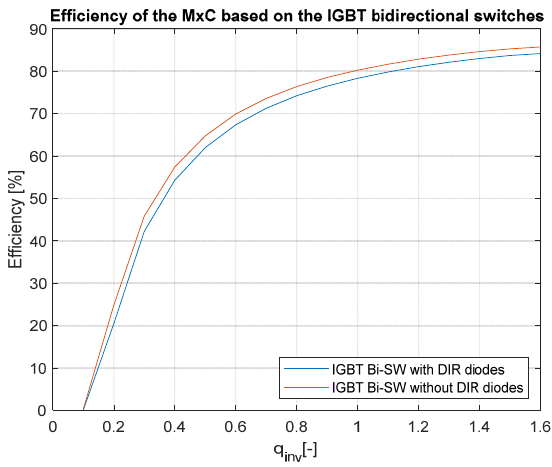
Figure 7. Efficiency comparison of IGBT simulations.